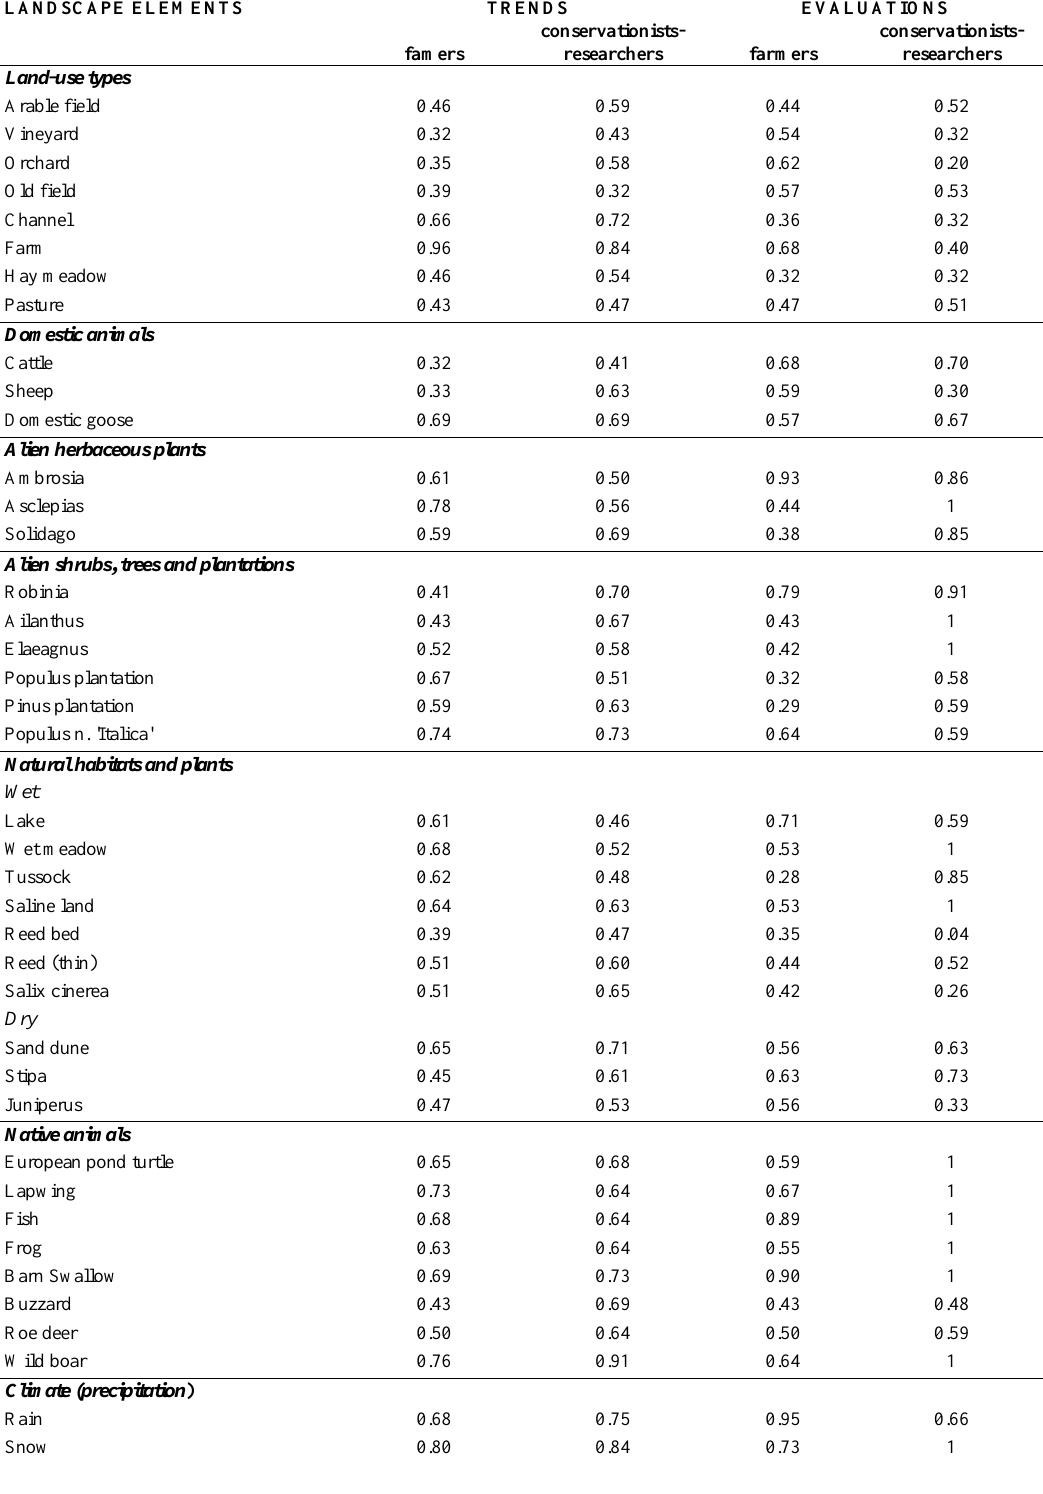
Table A1.1. Consensus values (Tastle and Wierman 2007) of the trend perceptions and evaluations according to farmers and